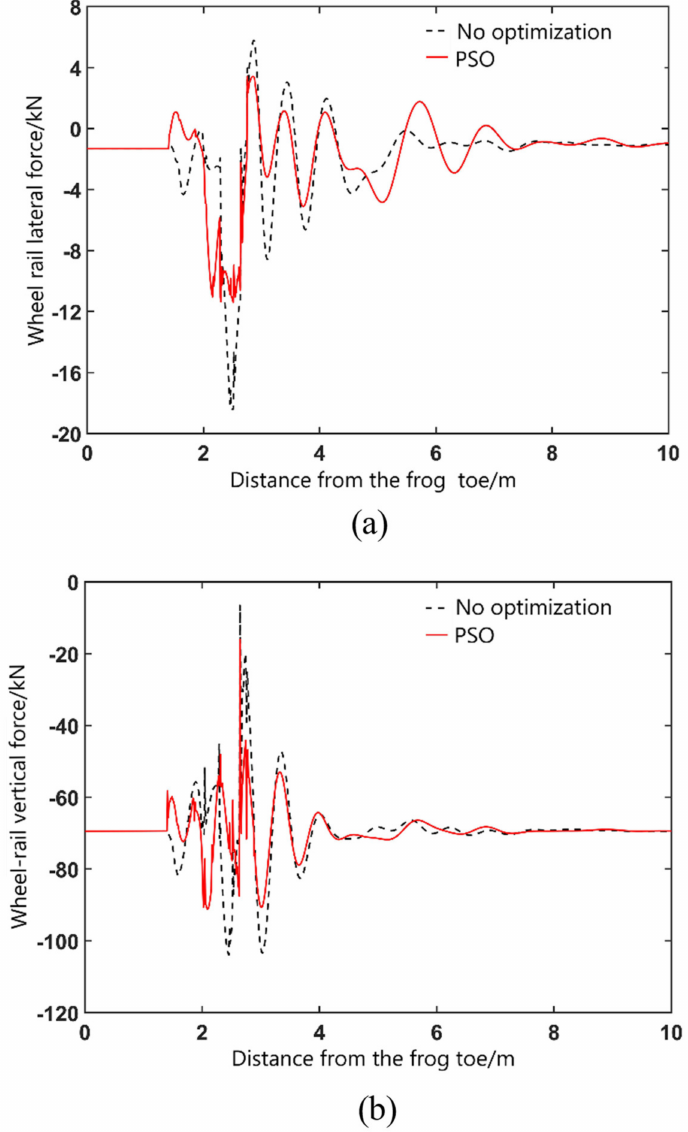
Figure 12. On the frog side: ( a ) Wheel/rail lateral force; ( b ) Wheel/rail vertical